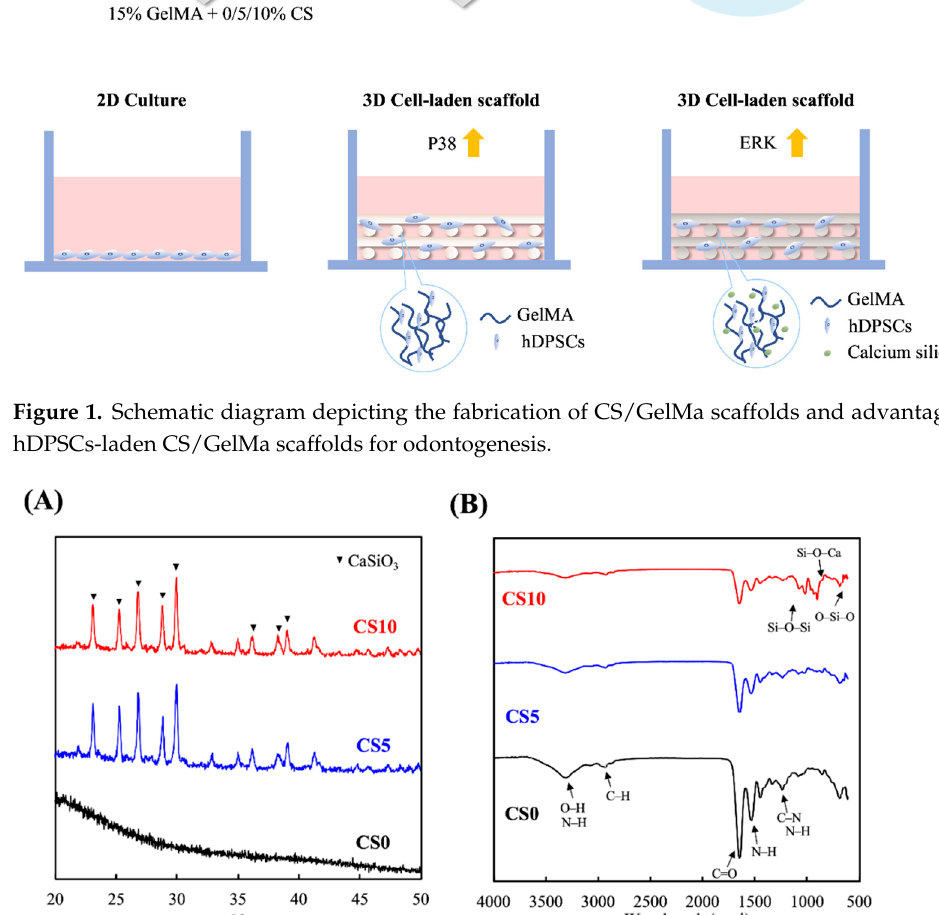
Figure 2. ( A ) X-ray diffractometry (XRD) and ( B ) Fourier-transform infrared spectrometer (FTIR) spectra of the CS/GelMa scaffolds.